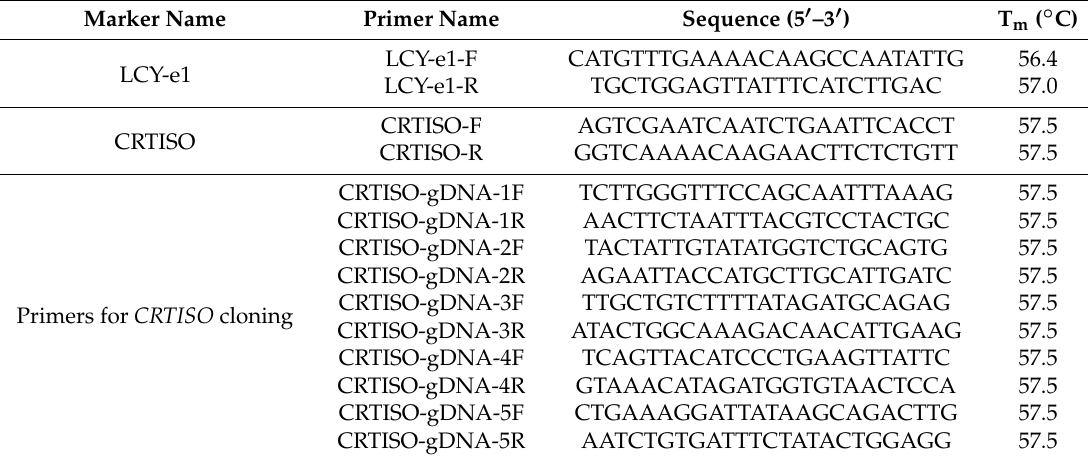
Figure 3. The variation in fruit color in LA4099 co-segregated with LCY-E in F 2 population derived from a cross between LA3475 and LA4099. ( A ) Gene structure of LCY-E and its genetic variation in LA4099. A DNA fragment of 1014 bp was inserted at the promoter region of LCY-E in LA4099; ( B ) Co-segregation analysis between LCY-E and the dark orange fruit colors in F 2 population of LA3475 × LA4099. The insertion at LCY-E was distinguished by a DNA marker (LCY-e1). The marker co-segregated with the fruit colors in 94 F 2 progenies derived from a cross of LA3475 and LA4099. O and R represent the orange and red fruit colors, respectively, in the parental lines and F 2 population. M indicates 1 kb DNA ladder. Table 2. Primers of LCY-E and CRTISO used for sequence analysis and